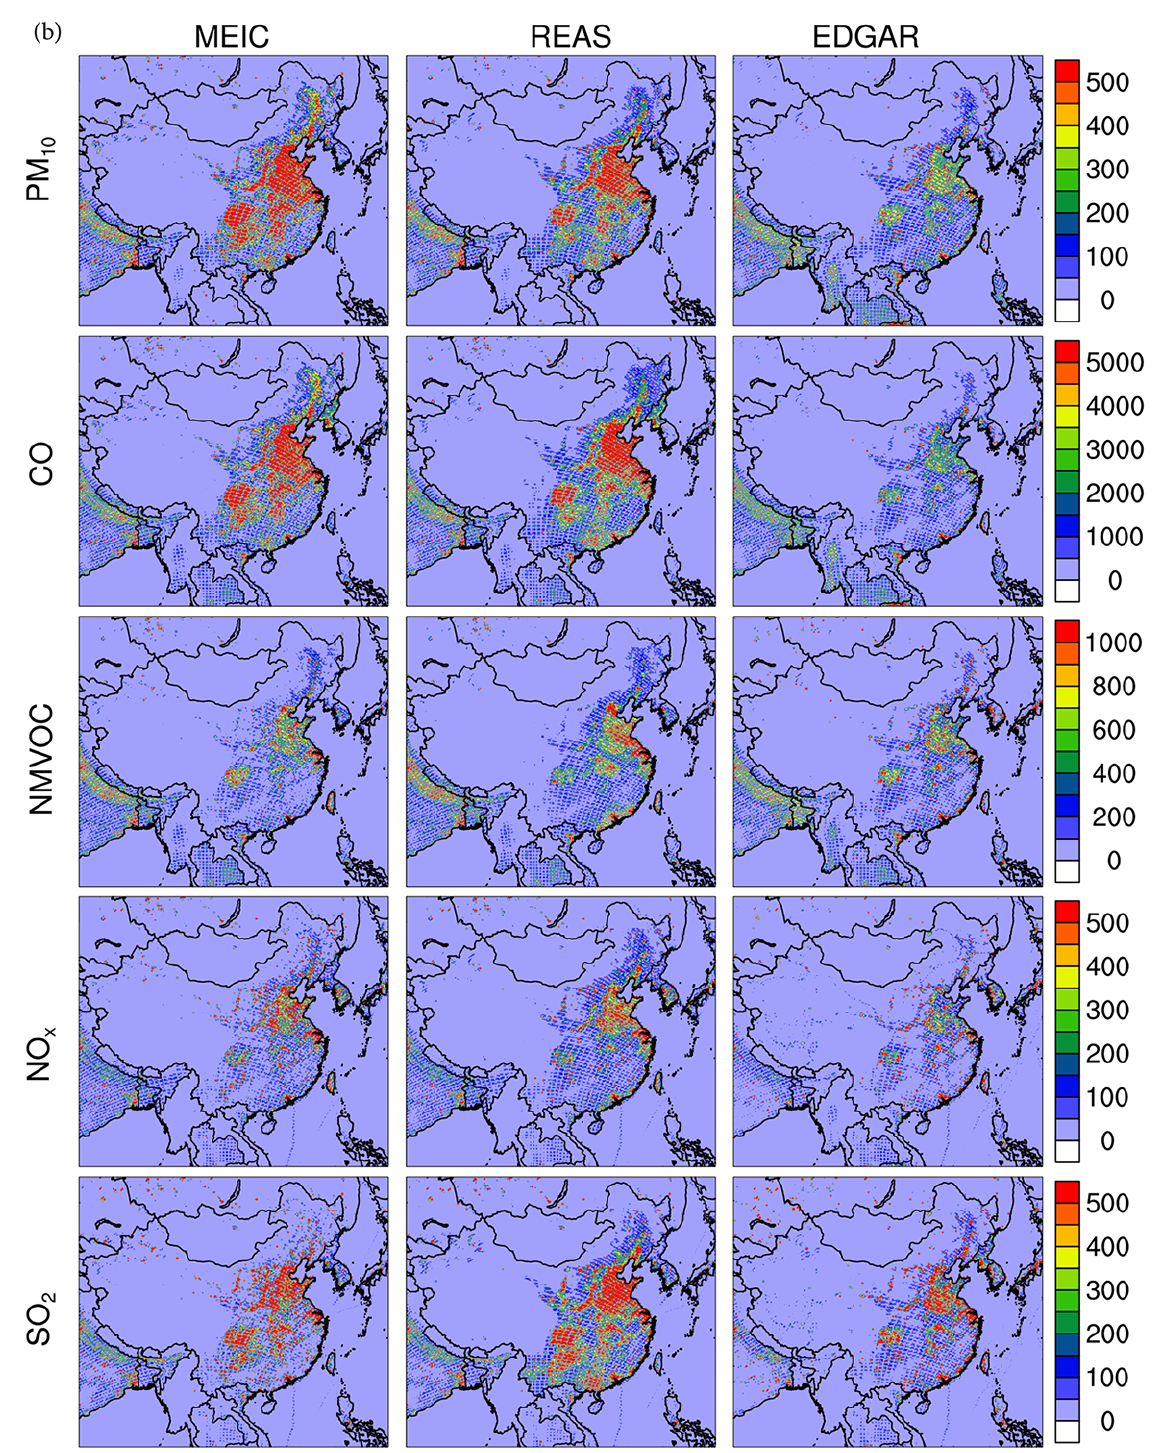
Figure 14. (a) Emissions of five pollutants (PM 10 , CO, NMVOC, NO x , and SO 2 ) in kgkm − 2 month − 1 in January 2008 of the three emissions inventories. (b) Emissions of five pollutants (PM 10 , CO, NMVOC, NO x , and SO 2 ) in kgkm − 2 month − 1 in July 2008 of the three emissions